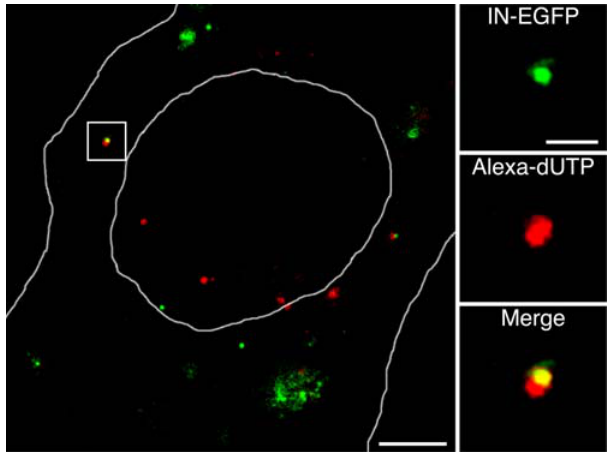
Figure 4. HIV-IN-EGFP virions containing neo-synthesized viral c-DNA can be visualized in infected cells. Confocal visualization of a HeLa cell at 6 hours after infection with HIV-IN-EGFP (green) viral supernatant incubated with deoxynucleotides Alexa-594-dUTP (red). The large panel shows the merged image where yellow indicates overlapping of green and red signals. Cell and nuclear shapes are outlined in white. Bar, 5 m m. Individual color and merged magnification images of the boxed region are shown in the right panels. Bar, 0.5 m m.